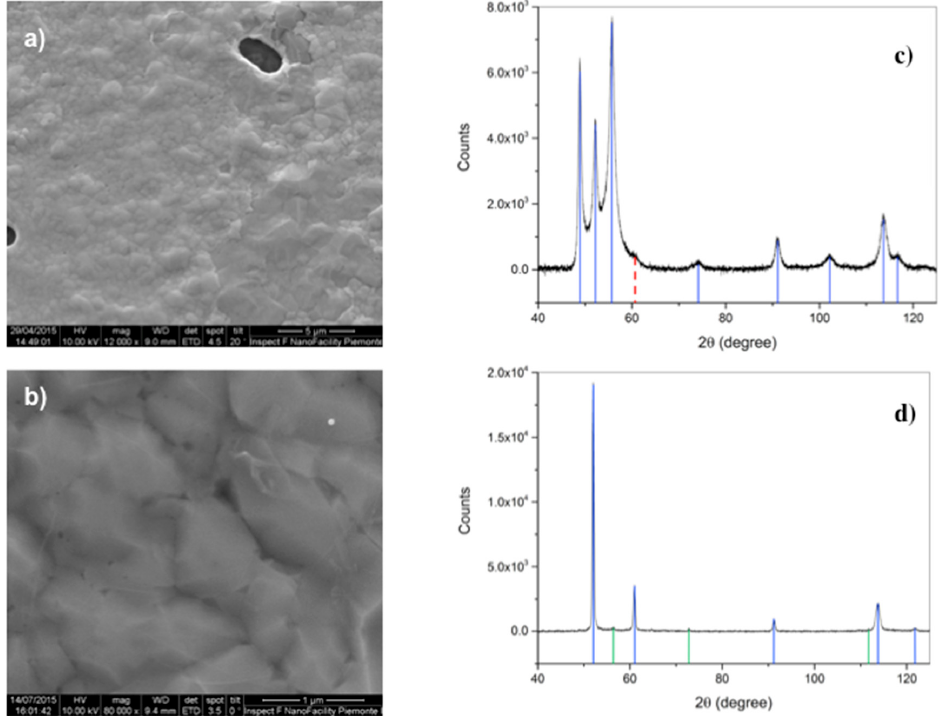
Figure 2. The surface morphology of the Co films after graphene deposition, observed by scanning electron microscopy at different magnifications, and revealing: ( a ) the formation of circular/elliptical holes in the metal, that in RTP (rapid thermal processing) samples are covered by graphene; and ( b ) the wrinkles of the graphene layer lying on the rough surface of Co. In ( c ) the X-ray diffraction spectra of the as deposited Co film, in which the Co hcp peaks are identified (blue lines), as well as the negligible fcc phase (dotted red line). In ( d ), the same for Co. after deposition where the Co fcc peaks are identified by blue lines. Green lines indicate Co silicide peaks .